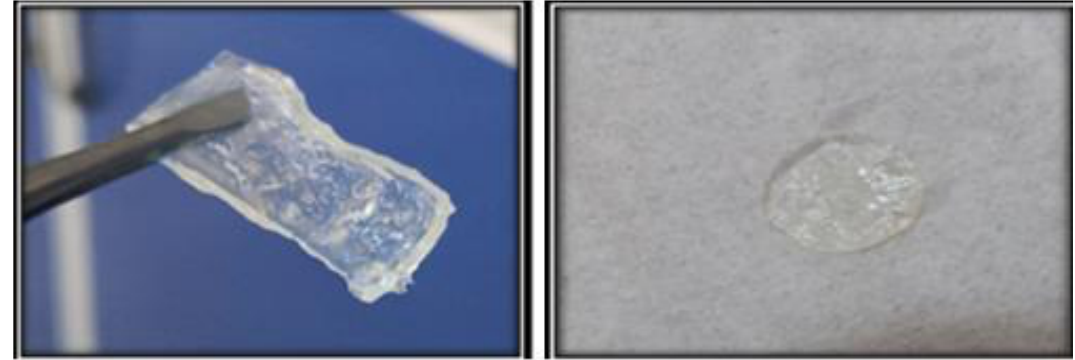
Fig. 10. Preparation of